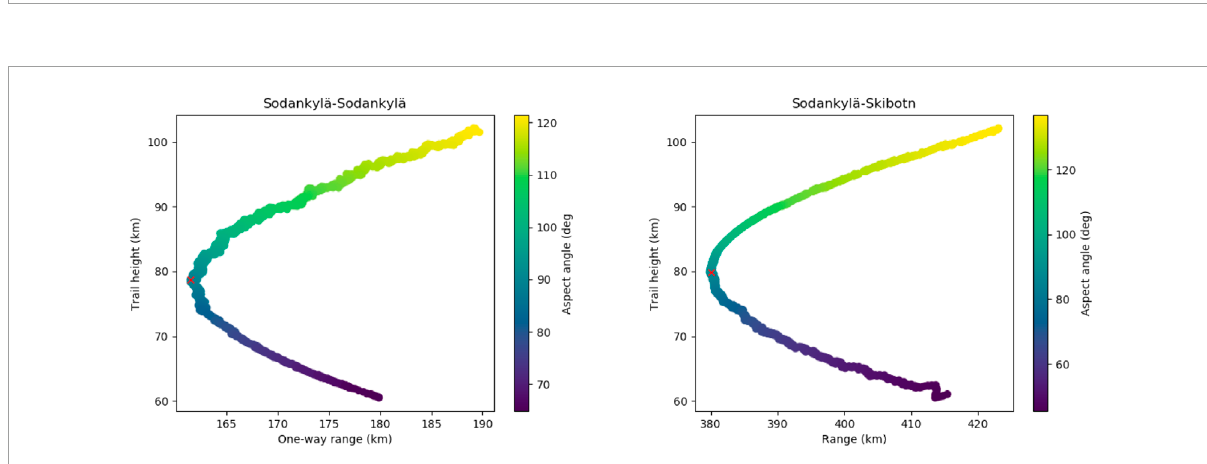
FIGURE 13 Left: Aspect angle of the Sodankylä ionosonde radar scatter along the meteor trail determined using the trajectory triangulated with meteor cameras. The position indicated with a red cross is where the scattering is specular. The horizontal axis shows the one-way virtual height as seen in the ionogram in Figure 12 . Right: The same, but for the oblique path between Sodankylä and Skibotn. In this case, the range on the horizontal axis is total propagation distance, assuming speed of light in vacuum, as shown in Figure 14 .